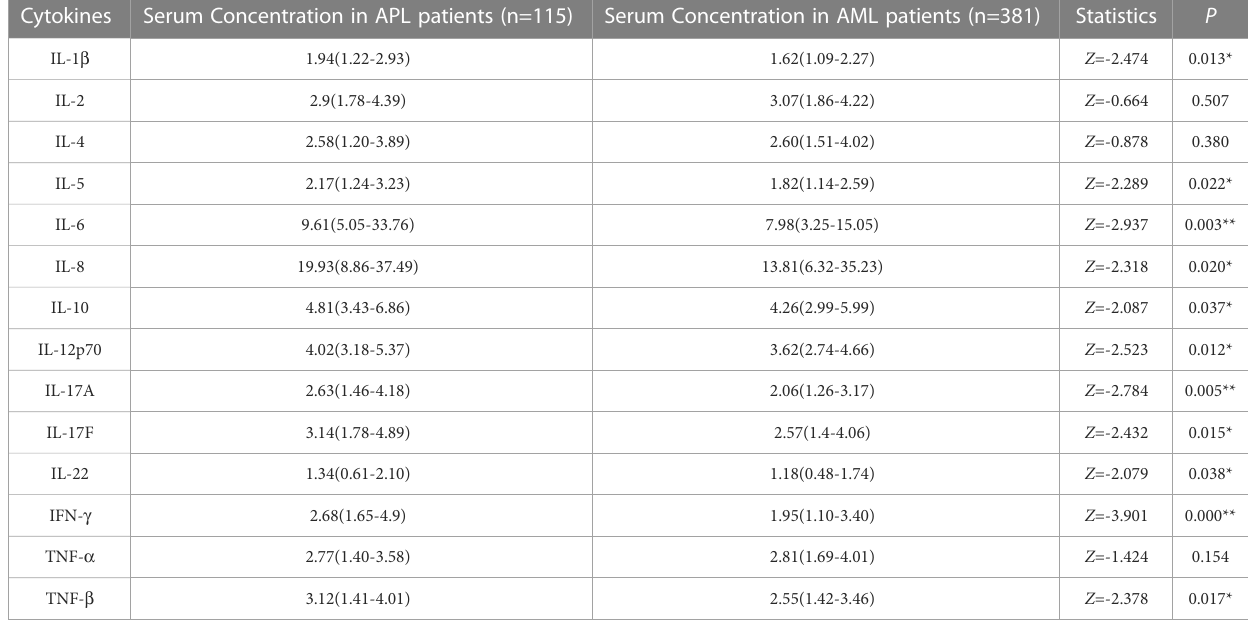
TABLE 3 Comparison of cytokine levels between newly diagnosed APL and AML (non-APL) patients (pg/ml, M[IQR] ). Cytokines Serum Concentration in APL patients (n=115) Serum Concentration in AML patients (n=381)